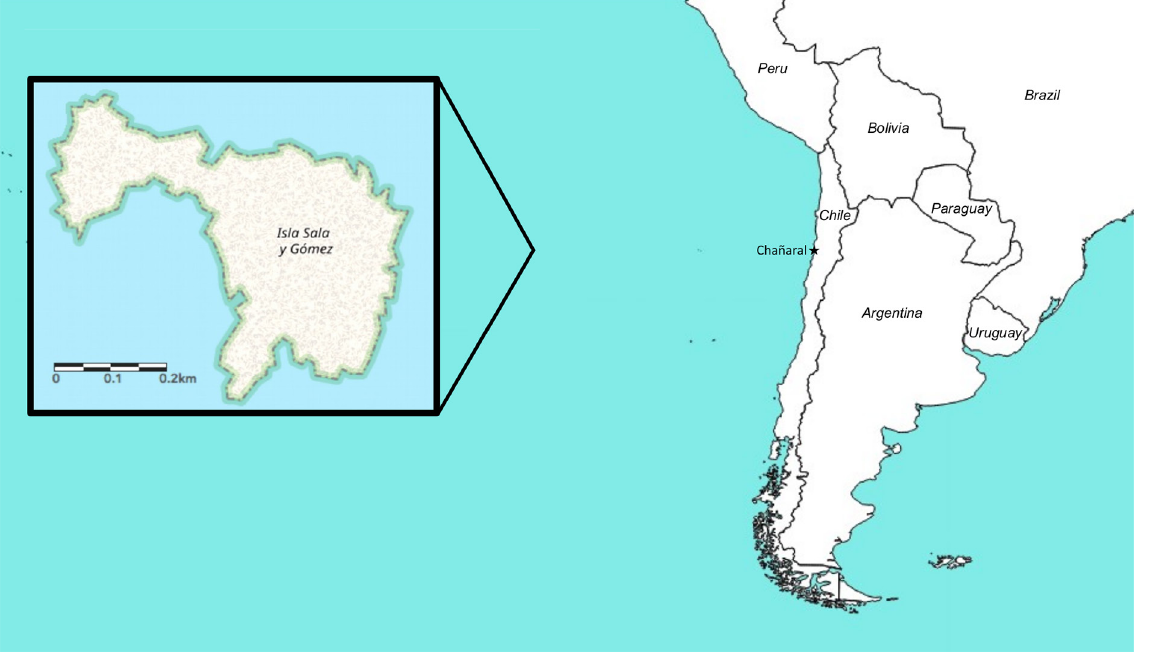
Fig. 1. Map of southern South America and Isla Sala y Gómez in detail. The islet is located approximately in front of Chañaral along the chilean